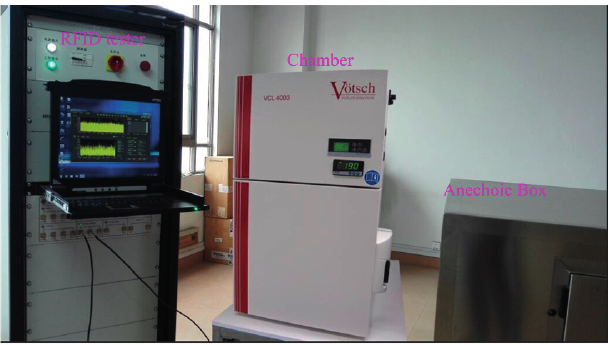
Figure 6. Photo of the proposed wireless humidity sensor.